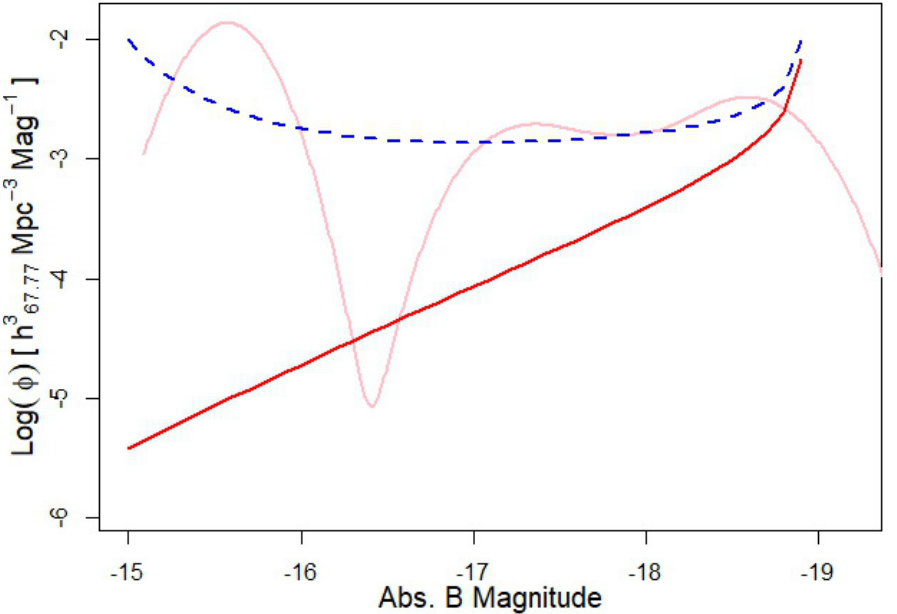
Figure 16. Luminosity functions for the CGS [54] faint galaxies: uncorrected luminosity function of the sample ( ), luminosity function fit as corrected for the effective comoving volume of the galaxies in the sample ( ), and KDE check of the corrected luminosity function, showing the probability density based on actual galaxies ( ). The number of measured galaxies at M B > − 17mag was very small, accounting for the spikes below and above the functional fit correction. The corrected luminosity function produces reasonable galaxy abundances for the corrected sample. Galaxies in this regime are weighted for density calculations with this correction to produce the BHMF for all measurable local spiral